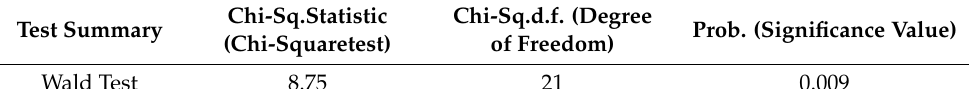
Table 18. Symmetry test at point 0.25. Test